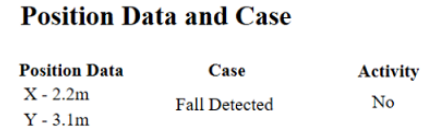
Fig.2.1. Web Navigation and Emergency